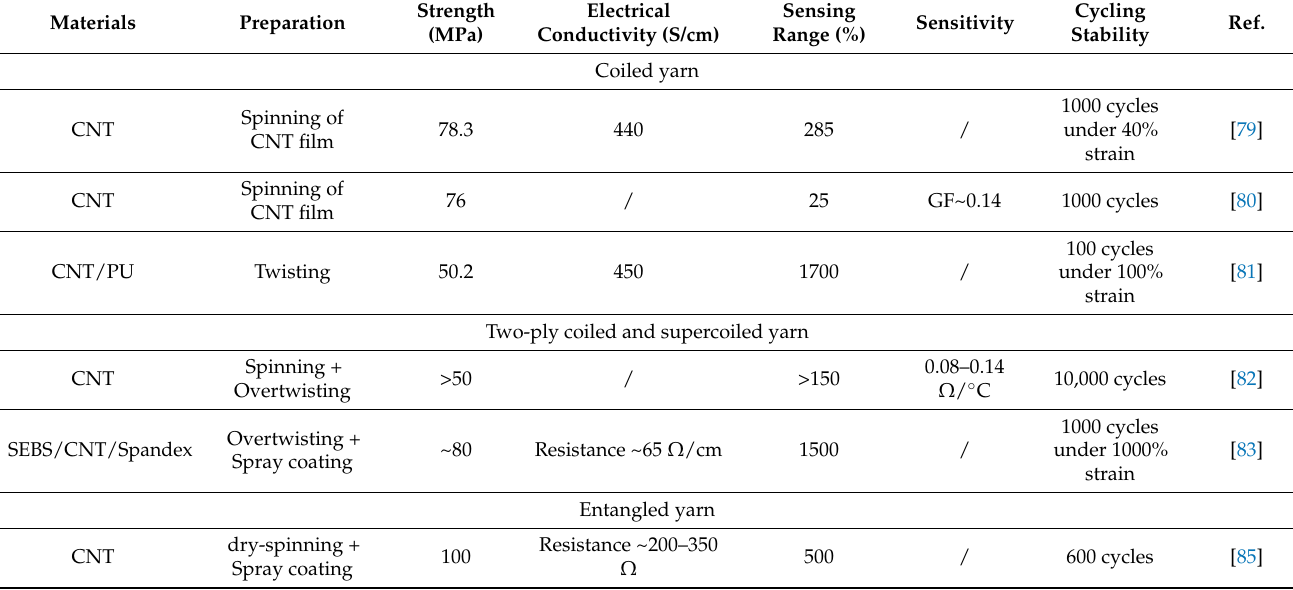
Figure 9. ( a ) Schematic of the spinning process of an entangled CNT yarn; ( b ) SEM image of entangled CNT yarn; ( c ) schematic of stretching the two ends of entangled CNT yarn for cyclic testing; ( d ) stress–strain curves at 500 strain over 10 cycles; and ( e ) relative resistance change of entangled yarns within 400 cycles. Reprinted with permission from Ref. [85]. 2013, American Chemical Society. Table 2. Brief summary of the configurations and corresponding sensing performance of conductive yarns.